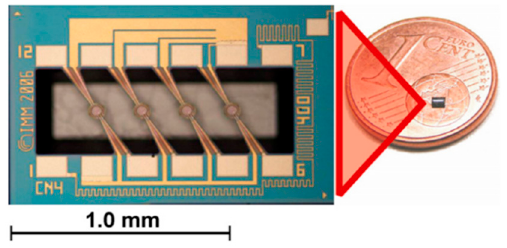
Figure 1. ULP MOX-based sensor matrix integrated into the RFID tag.